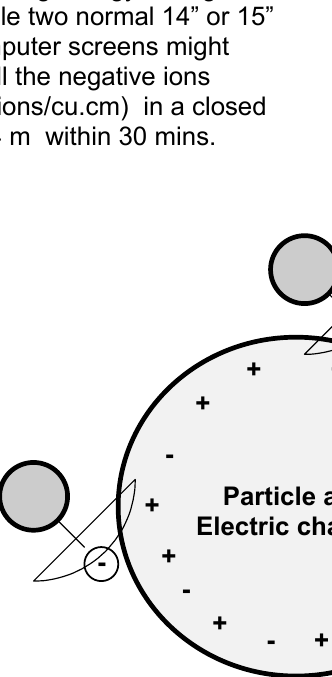
Figure 4: Cross section showing negative ions attracting a particle